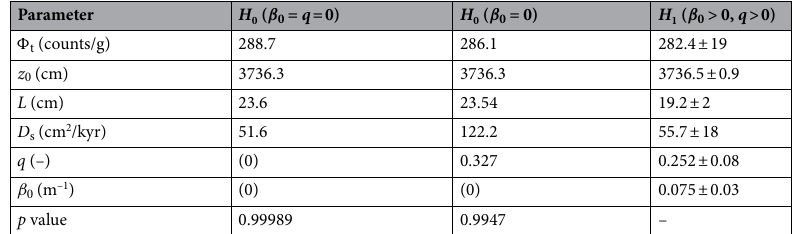
Table 1. Poisson regression models for two null hypotheses H 0 (fixed parameters in parentheses) and the size segregation hypothesis H 1 . The p value represents the rejection probability of H 0 = H 1 , obtained from the test statistics − 2ln (cid:31) of the likelihood-ratio test. Error estimates for H 1 parameters correspond to the standard deviation of bootstrapped simulation of microtektite counts. Fixed parameters derived from the age model and from physical properties are v b = 3.8 cm/kyr, ϕ s = 0.6, ρ s = 2.6 g/cm 3 , s 0 = 10 µm, ψ c = 3, and ϕ s ( z 0 )/ϕ s ( L )